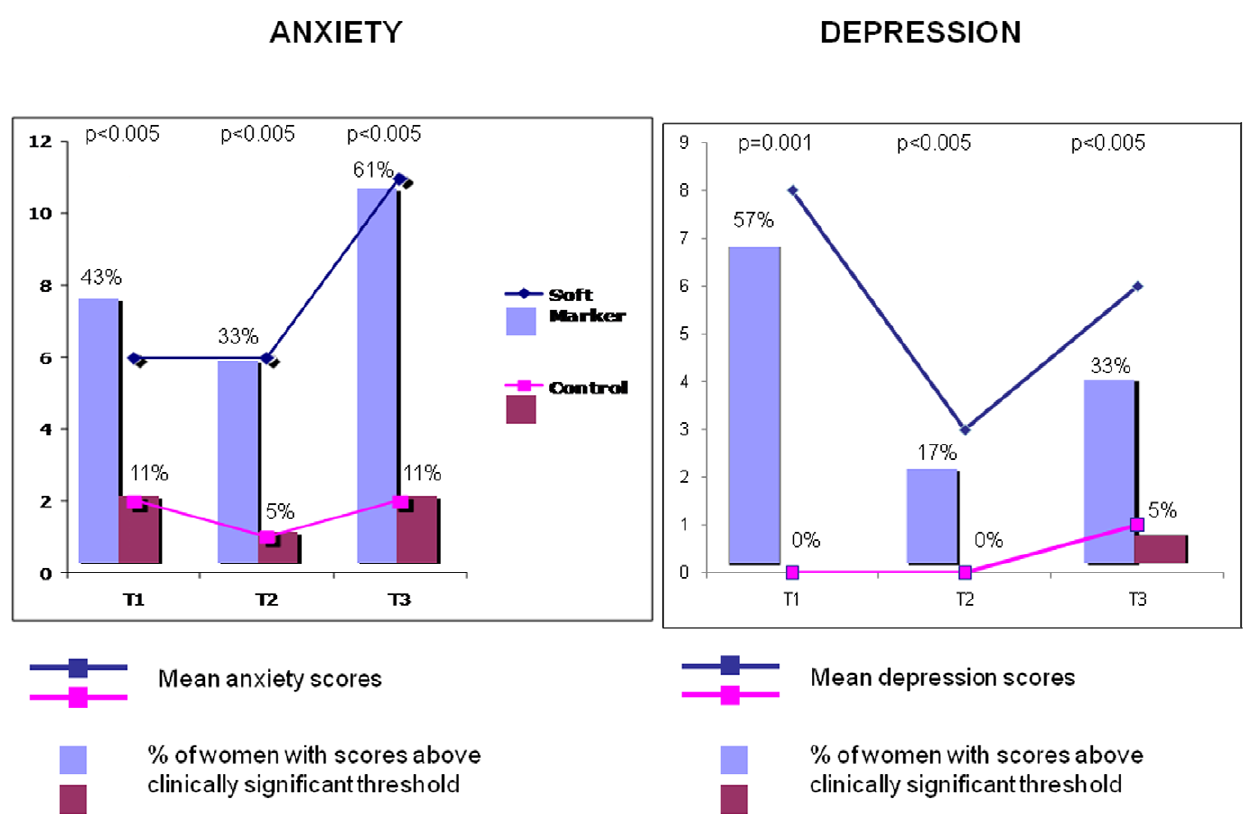
Figure 2. Maternal anxiety and depression over time. Mean scores are given for anxiety and depression (lines). Percentages indicate the number of participants with anxiety (or depression) scores above the scale clinical threshold (bars). T1=Third trimester during pregnancy, T2=Birth, T3=2 months after birth.